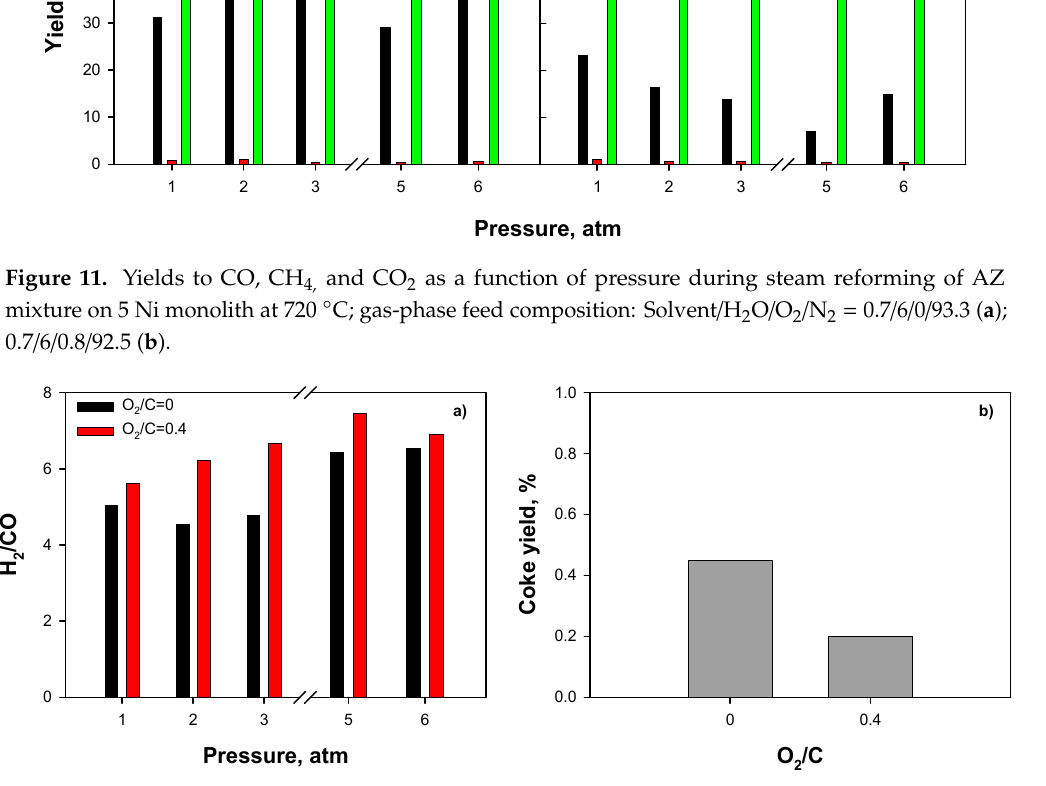
Figure 12. ( a ) H 2 / CO ratio as a function of pressure during steam reforming of AZ mixture on 5 Ni monolith at 720 ◦ C; gas-phase feed composition: Solvent / H 2 O / O 2 / N 2 = 0.7 / 6 / 0 / 93.3; 0.7 / 6 / 0.8 / 92.5. ( b ) Coke yields as a function of the O 2 / C ratio.